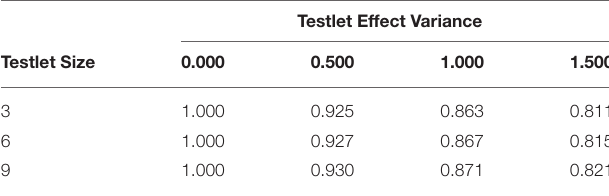
TABLE 1 | Scaling factors to transform MTIRT item difficulties to MIRT item difficulties by testlet effect variance and testlet